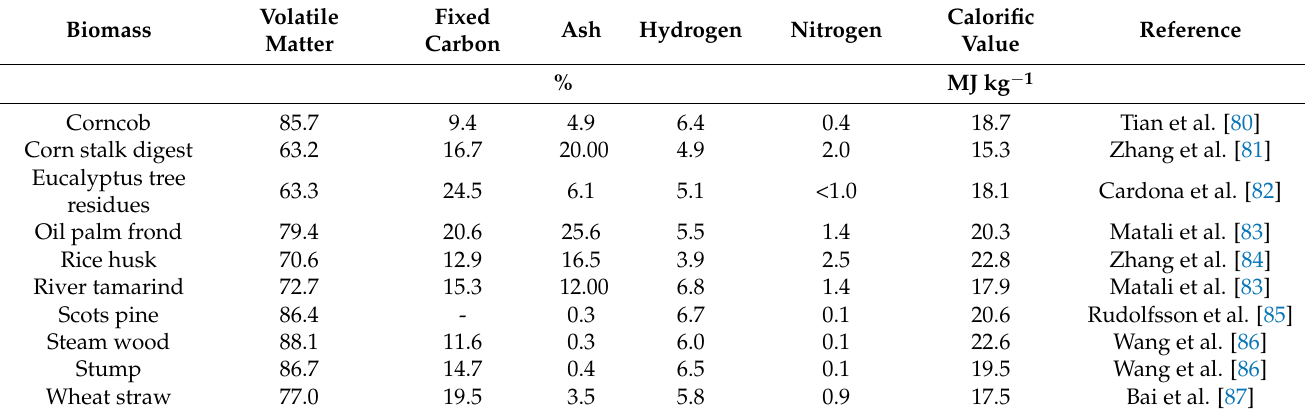
Table 4. The physico-chemical parameters of selected biomasses